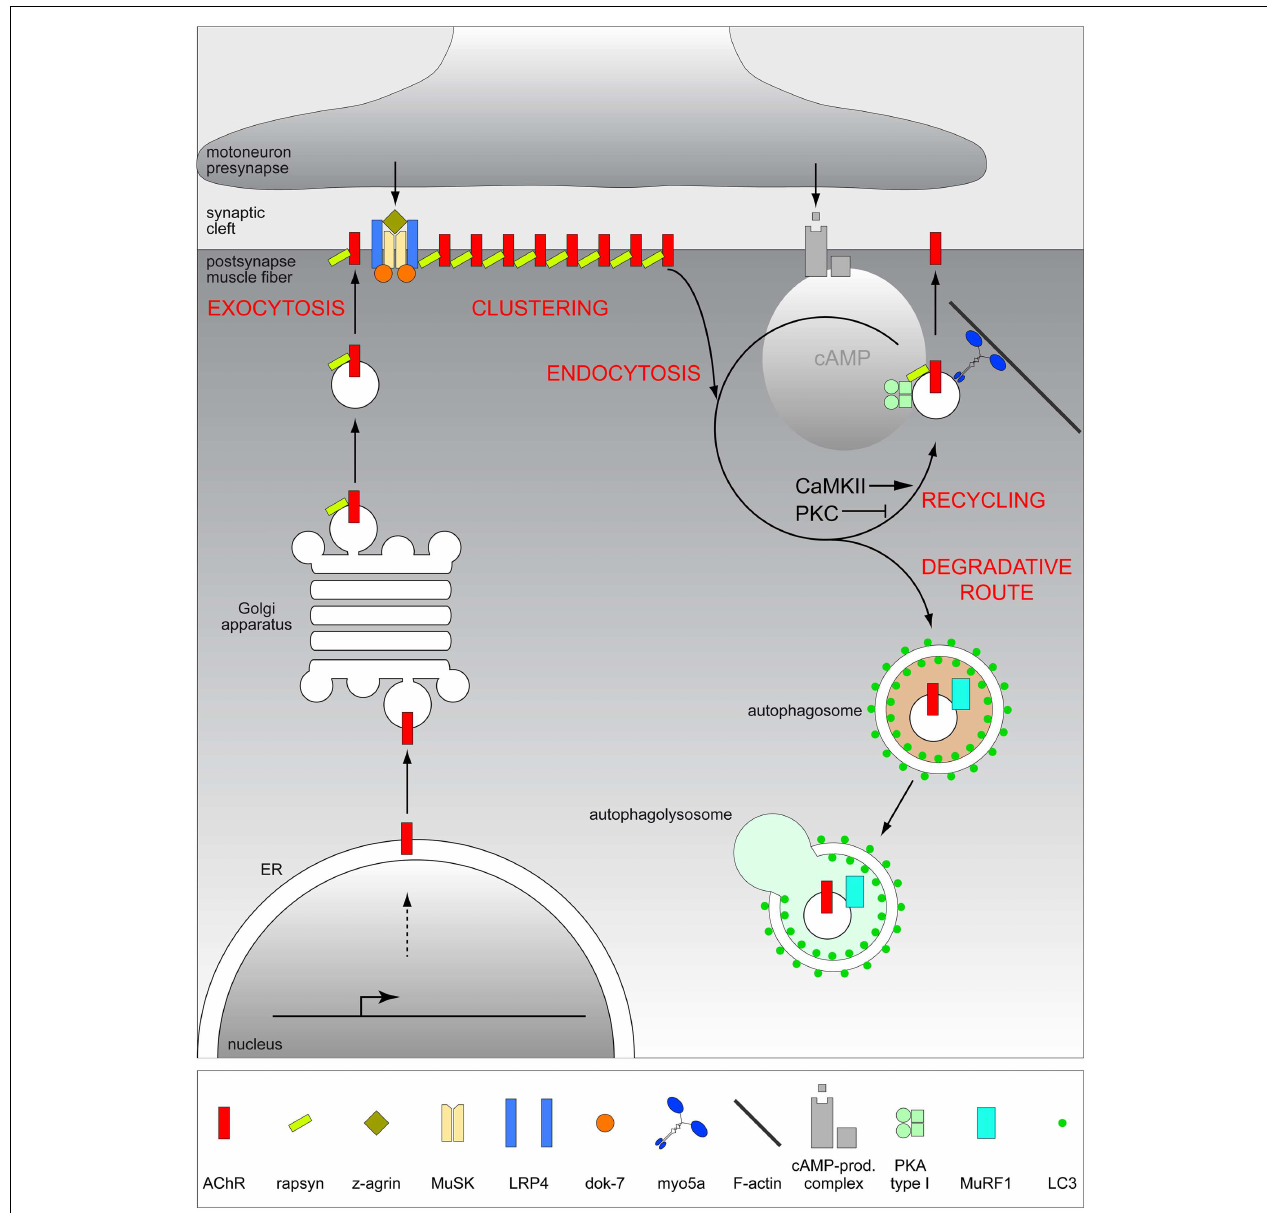
AChR is endocytosed and can then be recycled using a cooperative function of myosinVa, PKA type I, and rapsyn, or degraded, presumably via autophagic decay in a MuRF1-dependent manner. Decision-making between recycling or degradation appears to be subject to manifold signals including CaMKII and